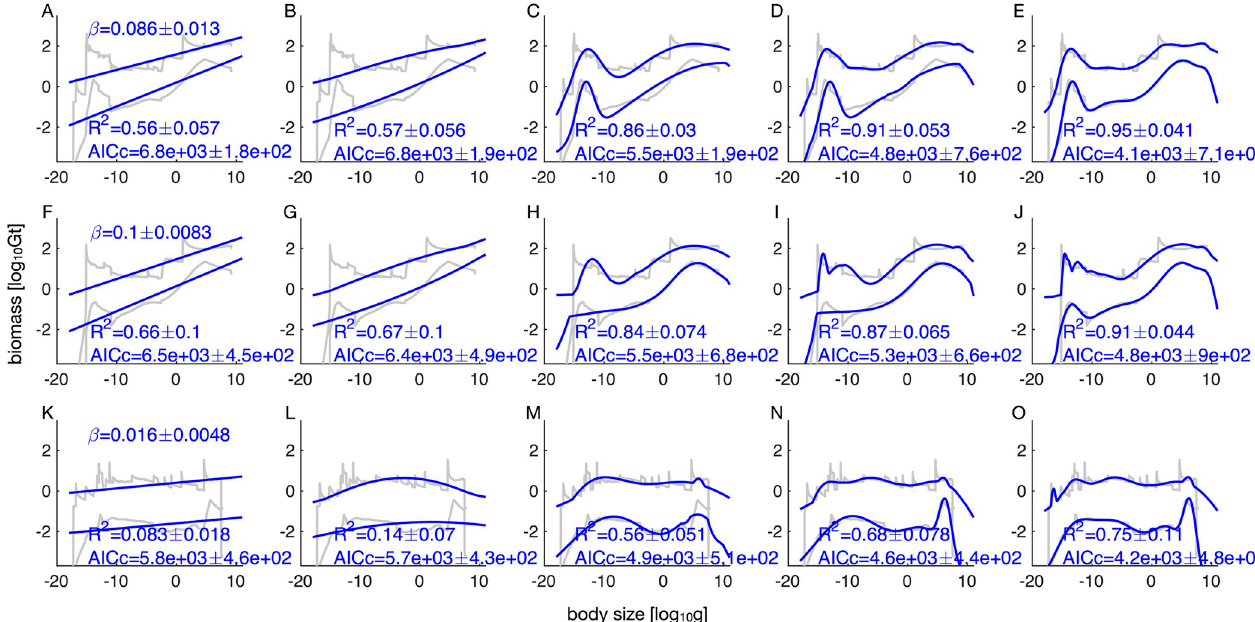
Fig 4. Regression analyses. Rows represent habitat realms (A to E: All realms, F to J: Terrestrial, K to O: Marine). Columns represent regression model types: (A, F, K: Linear, B, G, L: Gaussian, C, H, M: Gaussian mixture 2, D, I, N: Gaussian mixture 3, E, J, O: Gaussian mixture 4). Grey curves represent 95% confidence intervals of the data, and blue curves represent 95% confidence intervals of the model from 1000 bootstraps. For linear models, regression slopes are mean power exponents ± standard deviations across bootstraps. R 2 and AICc scores are means ± standard deviations across 1000 bootstraps.